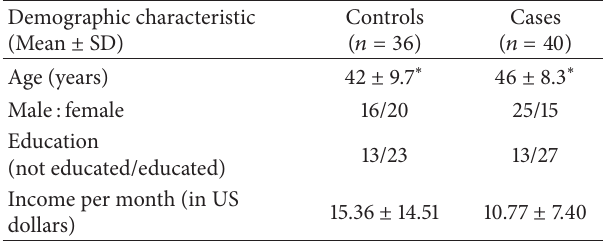
Table 3: Demographic characteristics of cases and